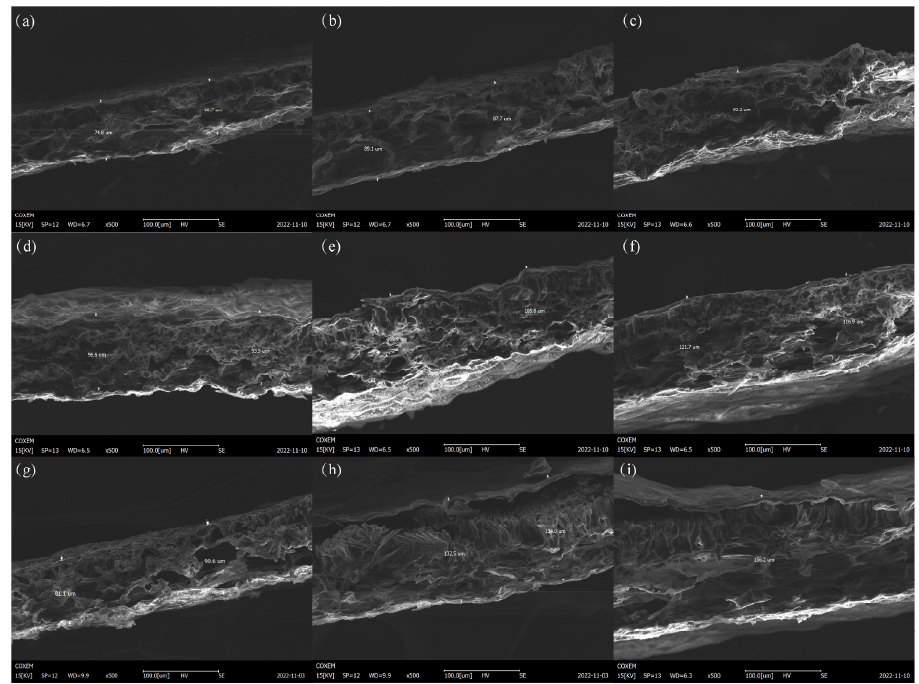
Figure 2. Electron microscope observations of leaf thickness in ‘Fengdanbai’ ‘Yinhongqiaodui’ and ‘Huhong’ cultivars of peony. ( a–c ): leaf thickness of ‘Fengdanbai’ (untreated, wilting, death); ( d–f ): leaf thickness of ‘Yinhongqiaodui’; ( g–i ): leaf thickness of ‘Huhong’. 3.2. Effects of High-Temperature Stress on Photosynthetic Characteristic Curve Parameters of Different Varieties of Peony Leaves The photosynthetic parameters of the three peony varieties were obtained by fitting a simplified model of the peony light – response mechanism model [25], and as shown in Table 3, high-temperature stress had different effects on the characteristic parameters of the light – response curves of the different varieties of peony leaves. The light saturation point (LSP) index and maximum net photosynthetic rate (Pn max ) showed a decreasing trend as stress progressed. The apparent quantum efficiency (AQE) of Hu Hong and Yinhongqiao showed a downward trend, while that of Feng Dan decreased first and then increased. On the contrary, the light compensation point (LCP) showed an overall increasing trend under high-temperature stress. During the initial stage of stress (0 – 2 days), ‘Fengdanbai’ changed the most dramatically, with an increase of 218.30%. There was no similar pattern in the changes in the dark respiration rate (Rd) in the leaves of different peony species. As shown in Table 4, the maximum net photosynthetic rate of different peony leaves under high-temperature stress was significantly and positively correlated with the change in the apparent quantum efficiency. Table 3. Effect of high-temperature stress on the characteristic parameters of light – response curves of Fengdanbai’ ‘Yinhongqiaodui’ and ‘Huhong cultivars of peony leaves.